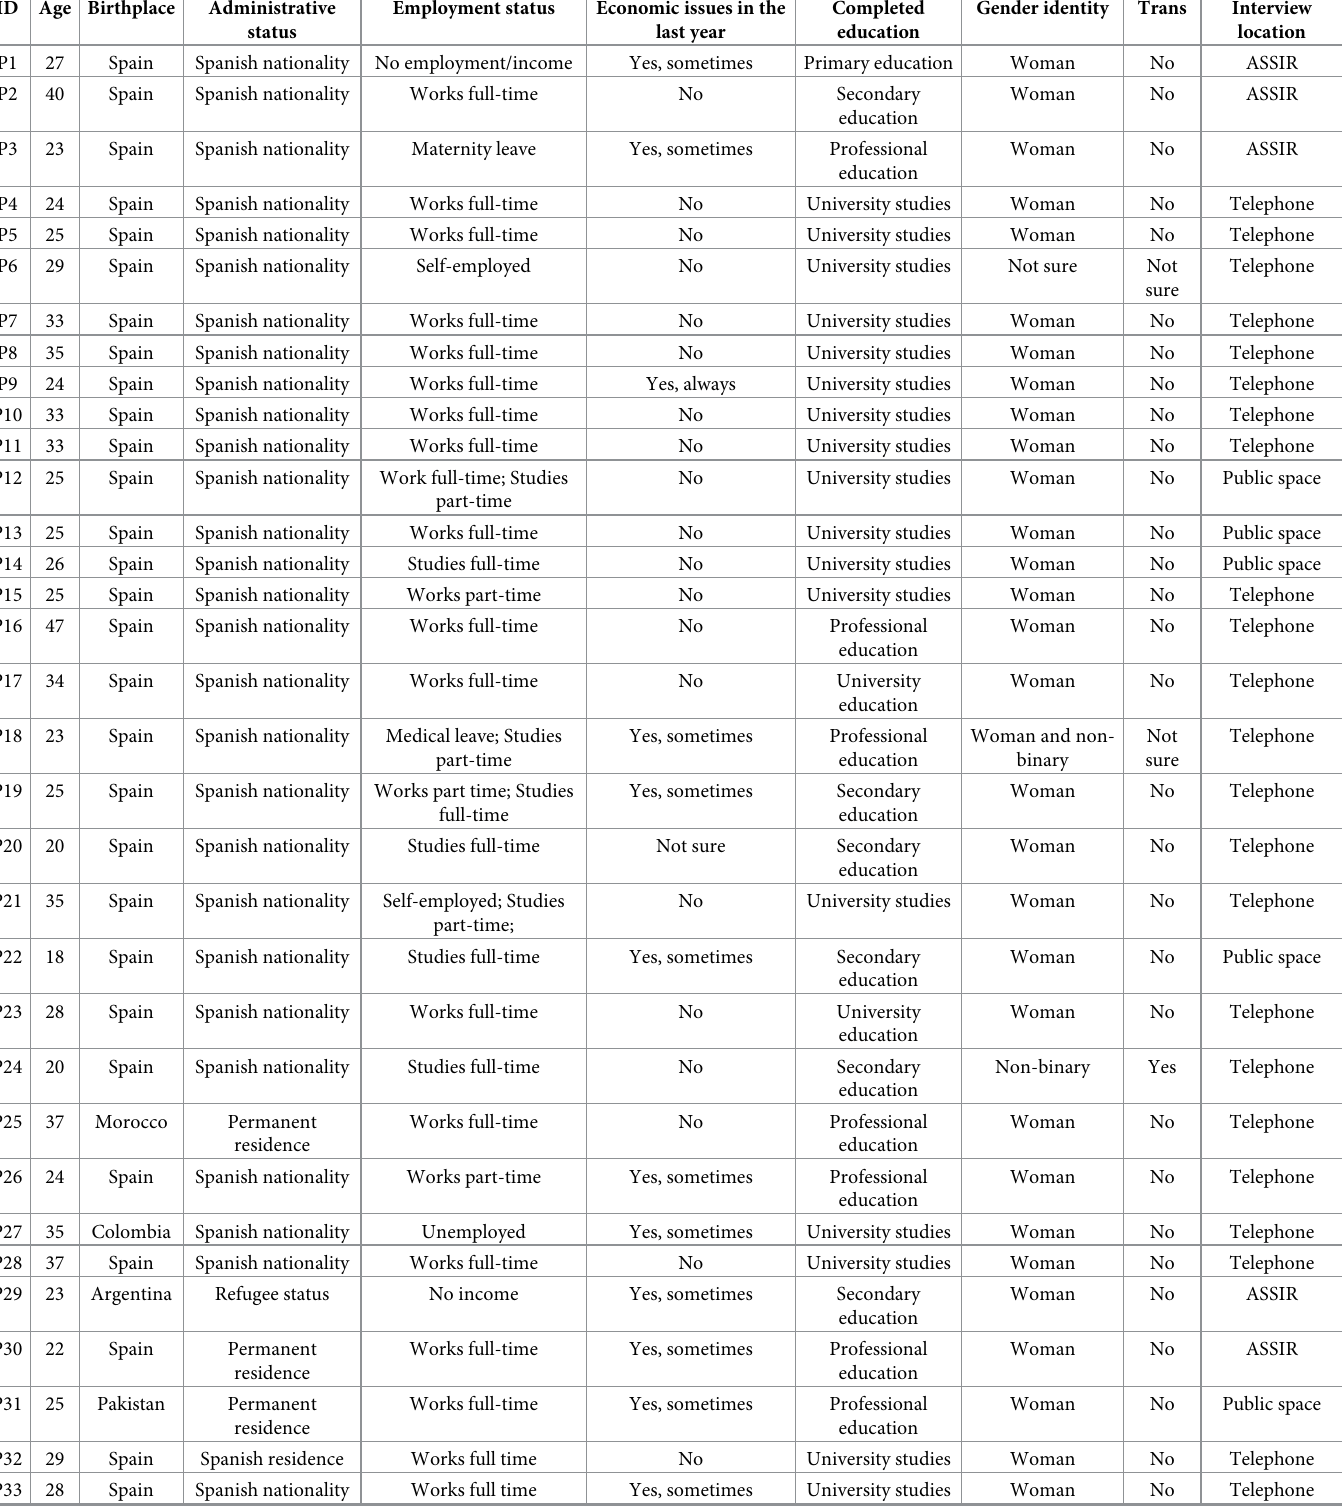
Table 2. Participant characteristics qualitative study (N =